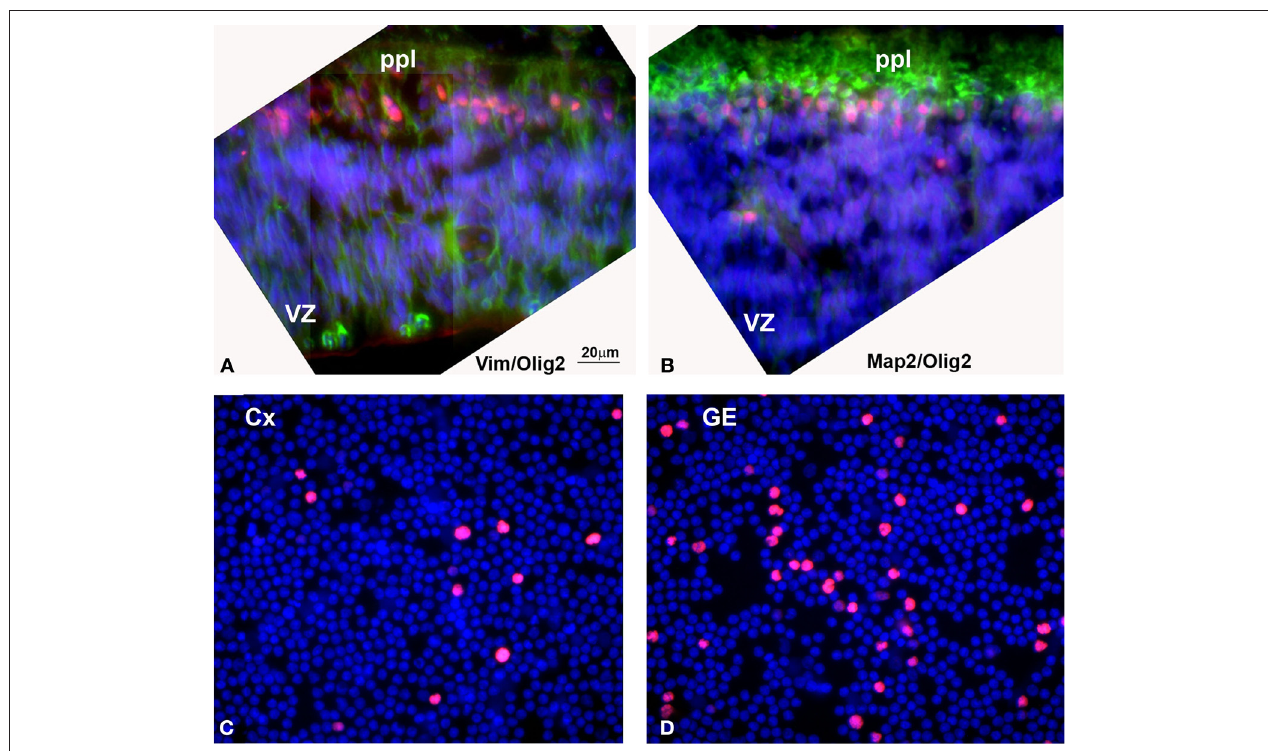
FIGURE 6 | (A, B) Olig2 expression in human embryonic (5 gw) forebrain. (A) Olig2 cells (red) in the primordial plexiform layer (ppl), but not in the ventricular zone (VZ), where vimentin + radial glia cells (green) are dividing. (B) Olig2 is expressed in nuclei of MAP2 + young neurons (green) at this stage. (C, D) Densities of Olig2 + cells (red) in the acute (4 h in vitro ) dissociated cell cultures from human cortical (Cx) and ganglionic eminence (GE) ventricular/ subventricular zones at midgestation (20 gw). Nuclei are counterstained by bisbenzamide (blue). Detailed quantifi cation was published by Jakovcevski and Zecevic